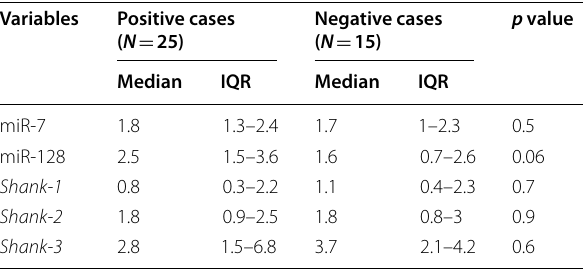
Table 5 Comparison between the expression of miRNA‑ 7, miRNA‑128 and SHANK family genes regarding associated